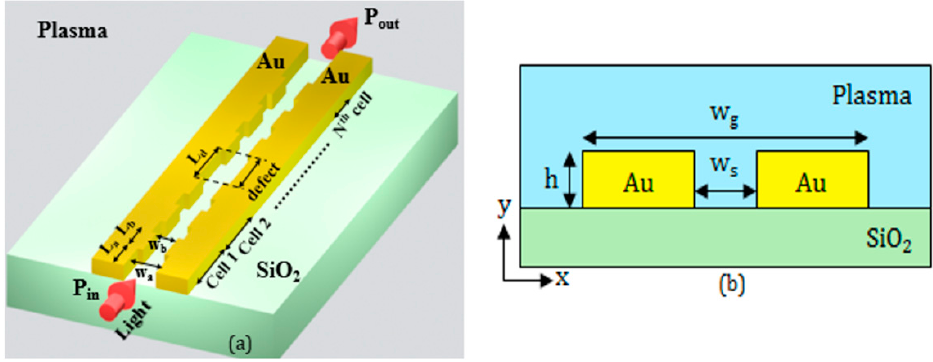
Figure 2. ( a ) Configuration of the plasmonic biosensor; ( b ) Cross-section of the plasmonic slotted waveguide.